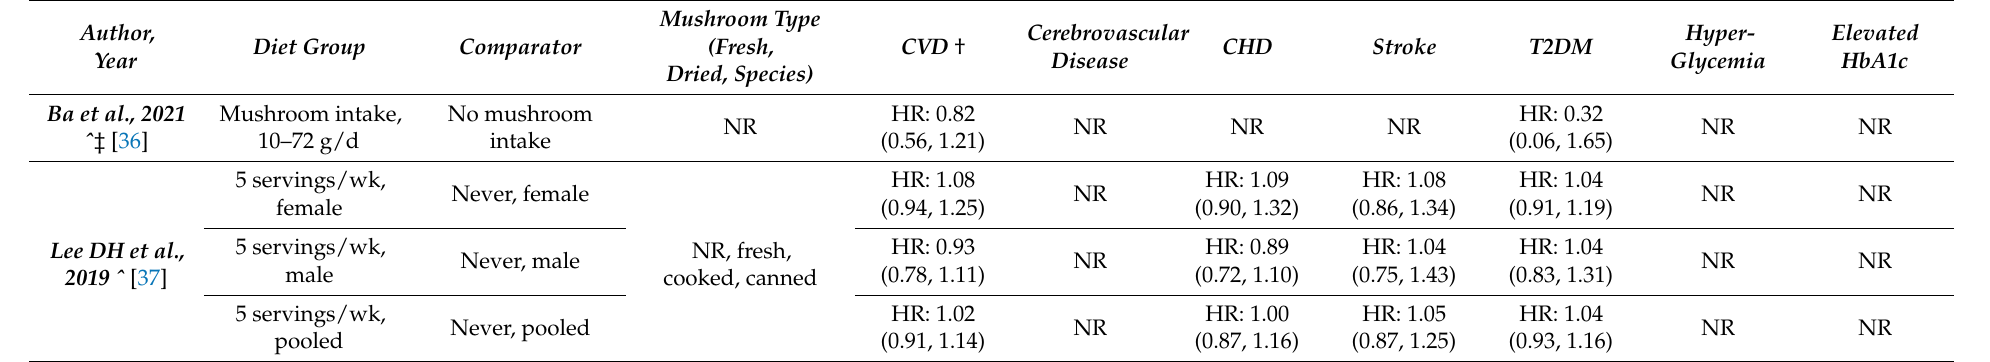
Table 7. Qualitative summary of studies evaluating cardiometabolic disease morbidities and mortality in